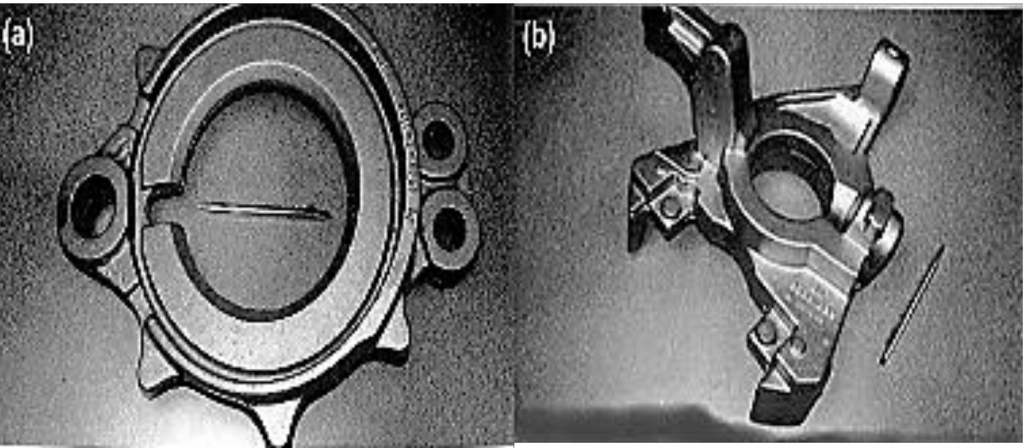
Figure 2. Graphite cast iron applications: ( a ) truck steering knuckle and ( b ) truck brake spider [14].